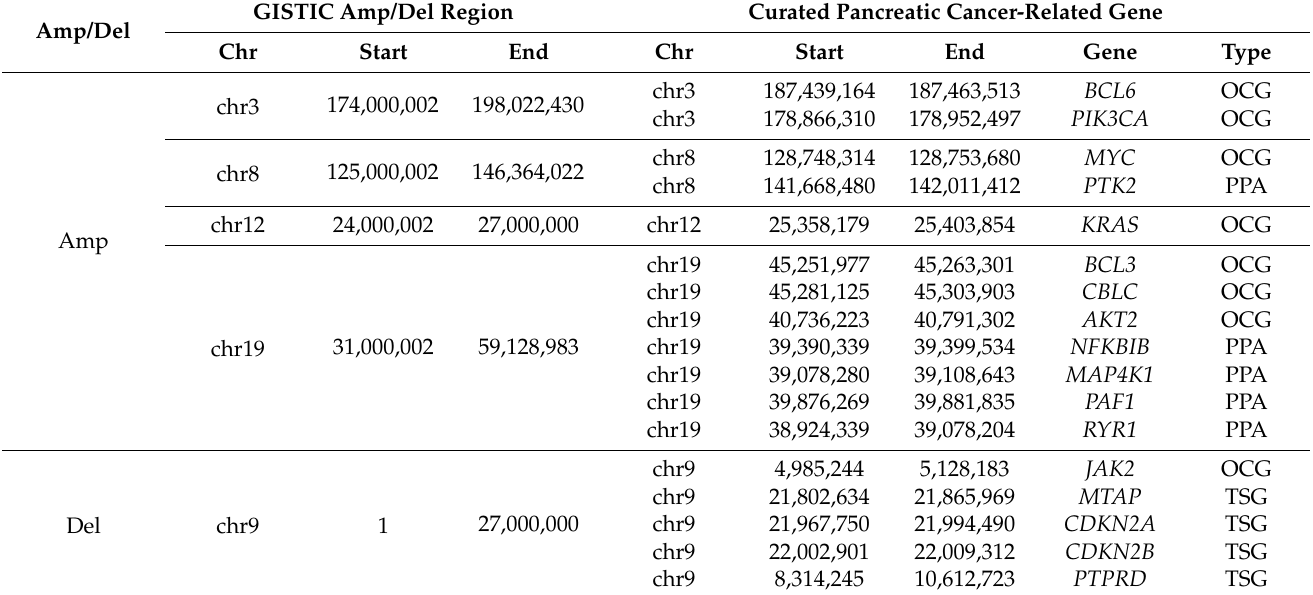
Table 3. Genomic coordinates of GISTIC regions containing known pancreatic cancer related